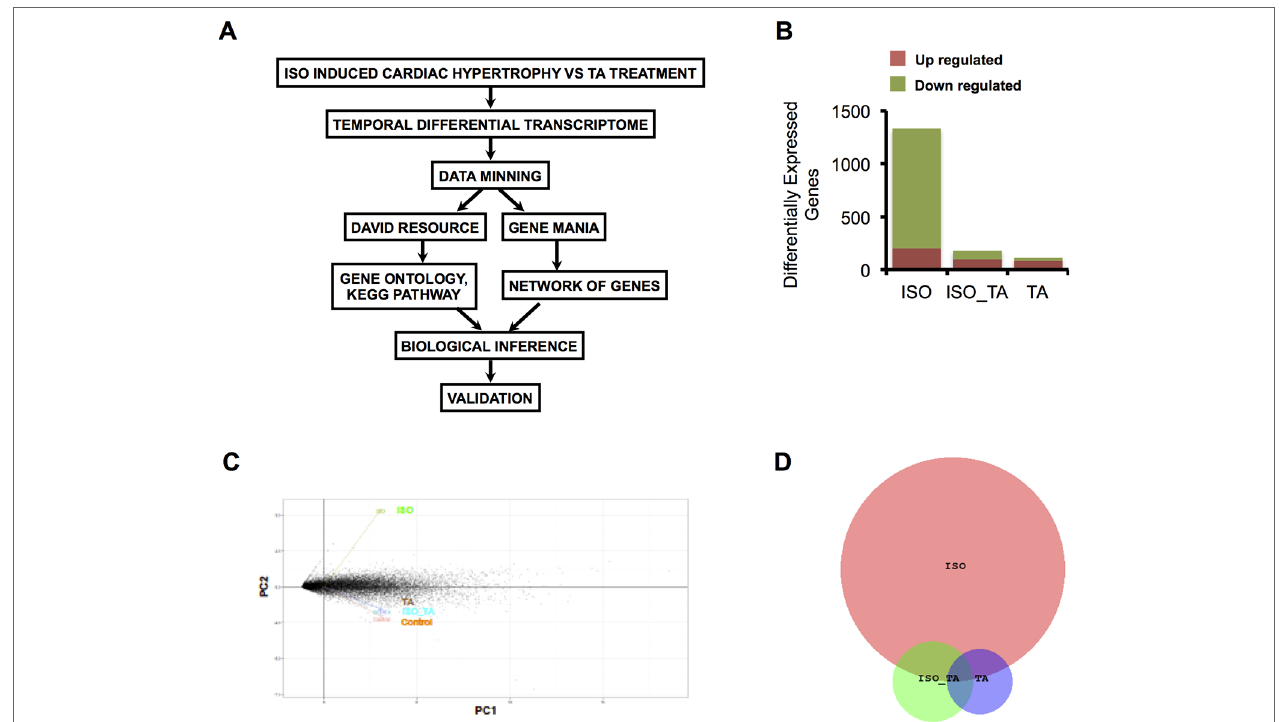
FIgURE 1 | (A) Scheme of data mining workflow for analyzing the transcriptome data. (B) The bar graph indicates the number of upregulated and downregulated gene in each condition. (C) Principal component analysis (PCA) of gene expression data sets from all three groups represented as two-dimensional plot of PC1 (Component 1) and PC2 (Component 2). (D) Venn Diagram representing overlap of differentially expressed Genes in ISO, ISO_TA, and TA groups. (Groups: ISO = ISO treated, ISO_TA = ISO + T. arjuna treated, TA, T. arjuna